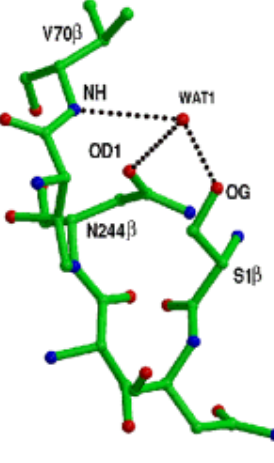
FIGURE 2 . Hydrogen bonding of a conserved water in precursor CA and active CA. The dotted lines represents hydrogen bonds ranging in 2.8–2.9 Å. (a) The conserved water of precursor CA. The OG atom of Ser1 β in the S1 β A precursor CA was modeled after the torsional geometry of the OG atom of Ser1 β residue of CA structure[2]. (b) The conserved water of CA. The conserved WAT1 is hydrogen bonded to 2 proton acceptors and 1 donor, which are also involved in chemical catalysis of